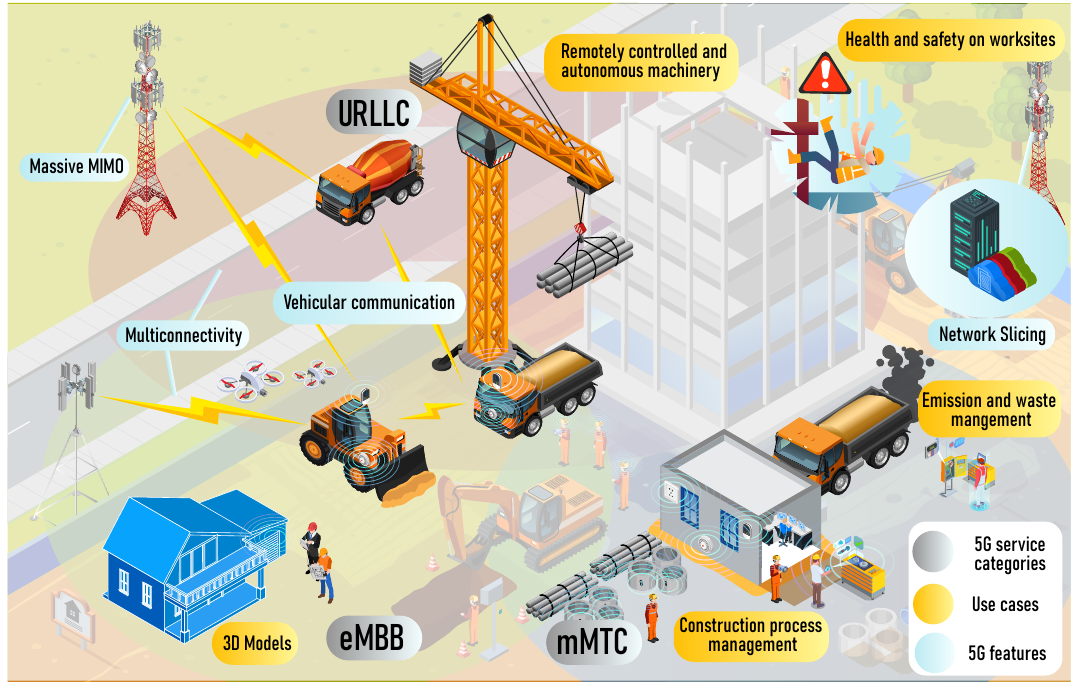
Figure 1. 5G at a